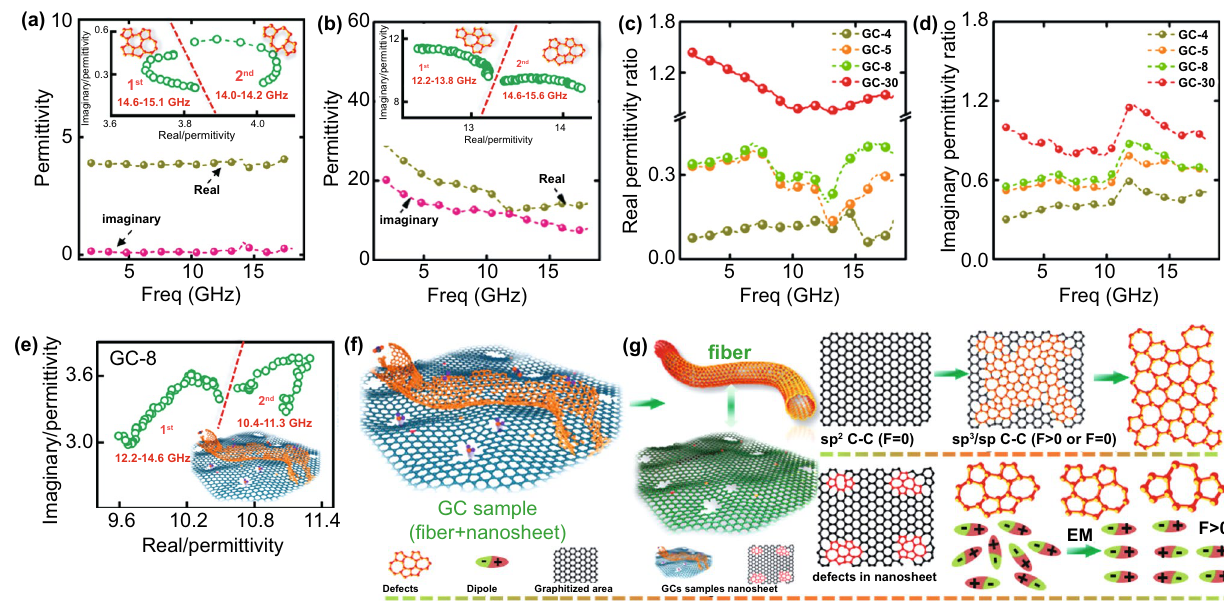
Fig. 6 Dielectric properties of GCs. a , b Permittivity parameters of C-lignin and C-cellulose. Inset shows the corresponding Cole–Cole plots. c , d The real permittivity ratio and imaginary permittivity ratio of GCs to C-cellulose. e Cole–Cole plots of GC-8. f , g Schematic illustration of the polarization–relaxation process. F represents the dipole